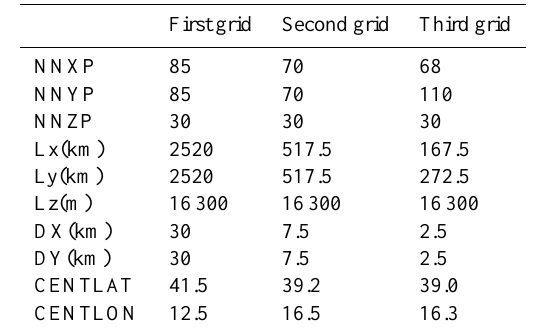
Fig. 2. The three RAMS